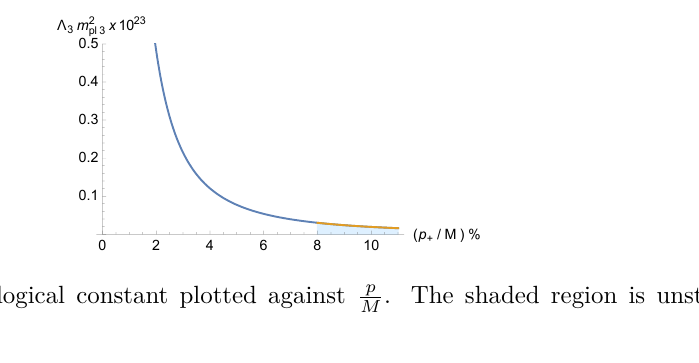
. The shaded region is unstable with M